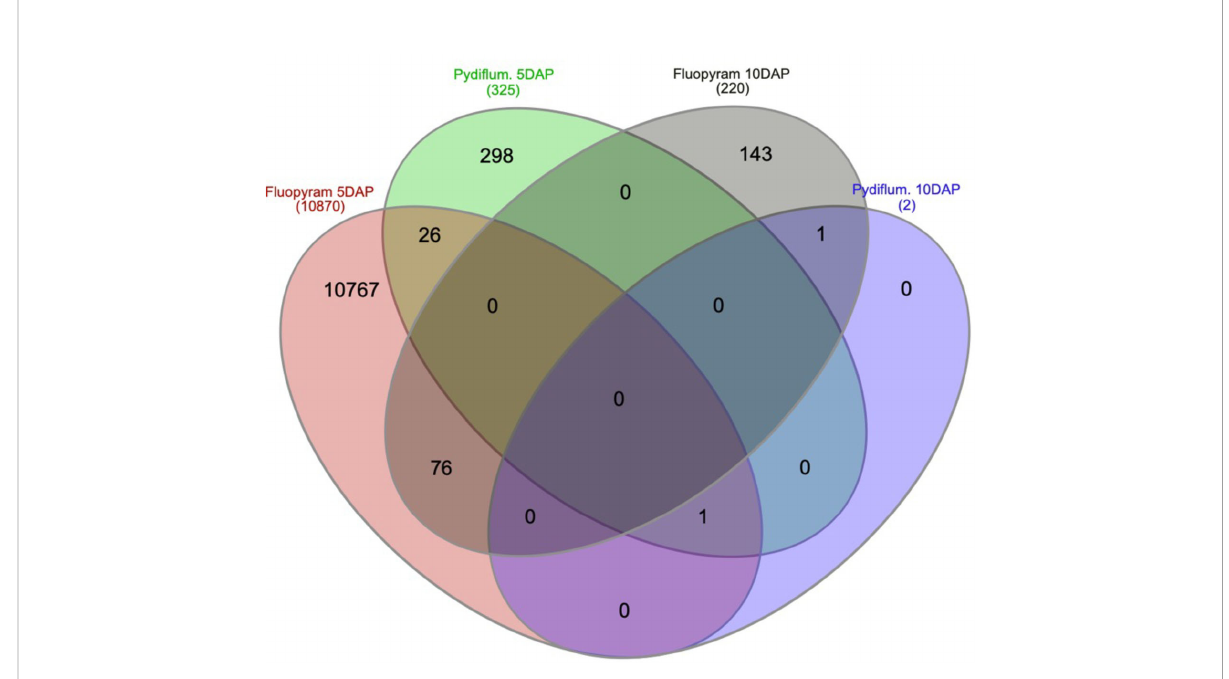
FIGURE 4 A Venn diagram plotting fi ltered DEGs with P-value<0.05 up and downregulated in soybean seedlings treated with fl uopyram and pydi fl umetofen, 5 and 10 days after planting (DAP). The number of DEGs shared between treatments is displayed by overlapping circles. All treatments were normalized against their respective controls (mock 5 DAP or mock 10